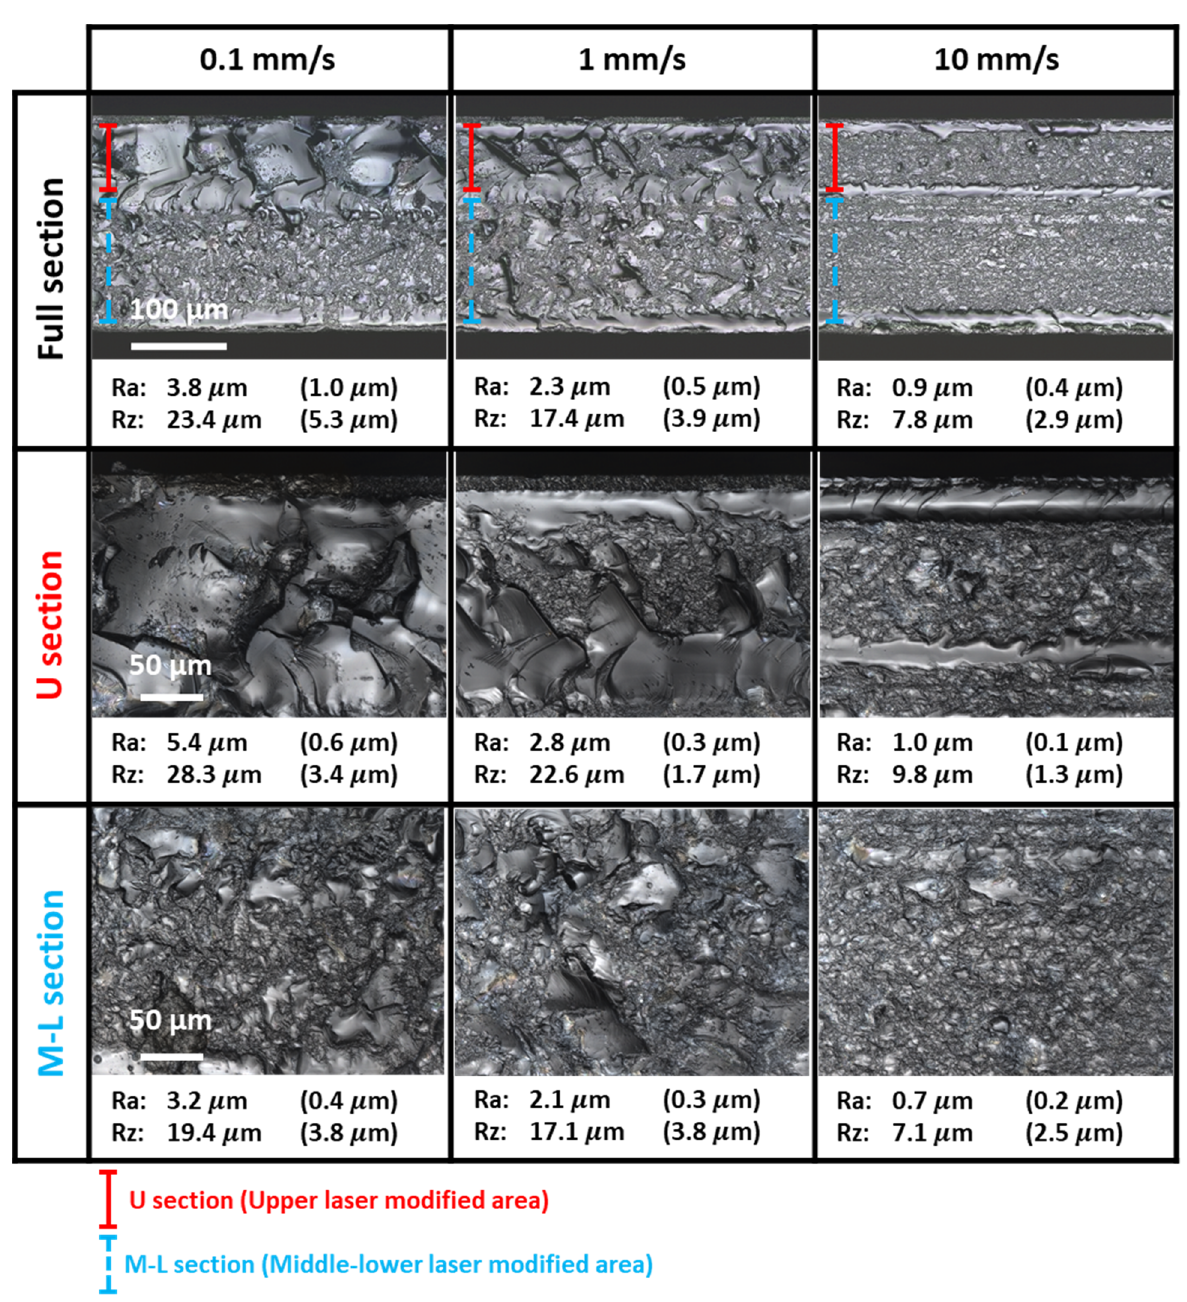
Figure 5. Sidewall profile laser-scanned images of cleaved MU samples at higher magnifications and roughness measurements Ra and Rz (with standard deviations). The solid red line indicates the upper laser-modified area; the dashed blue line indicates the middle-lower laser-modified area.